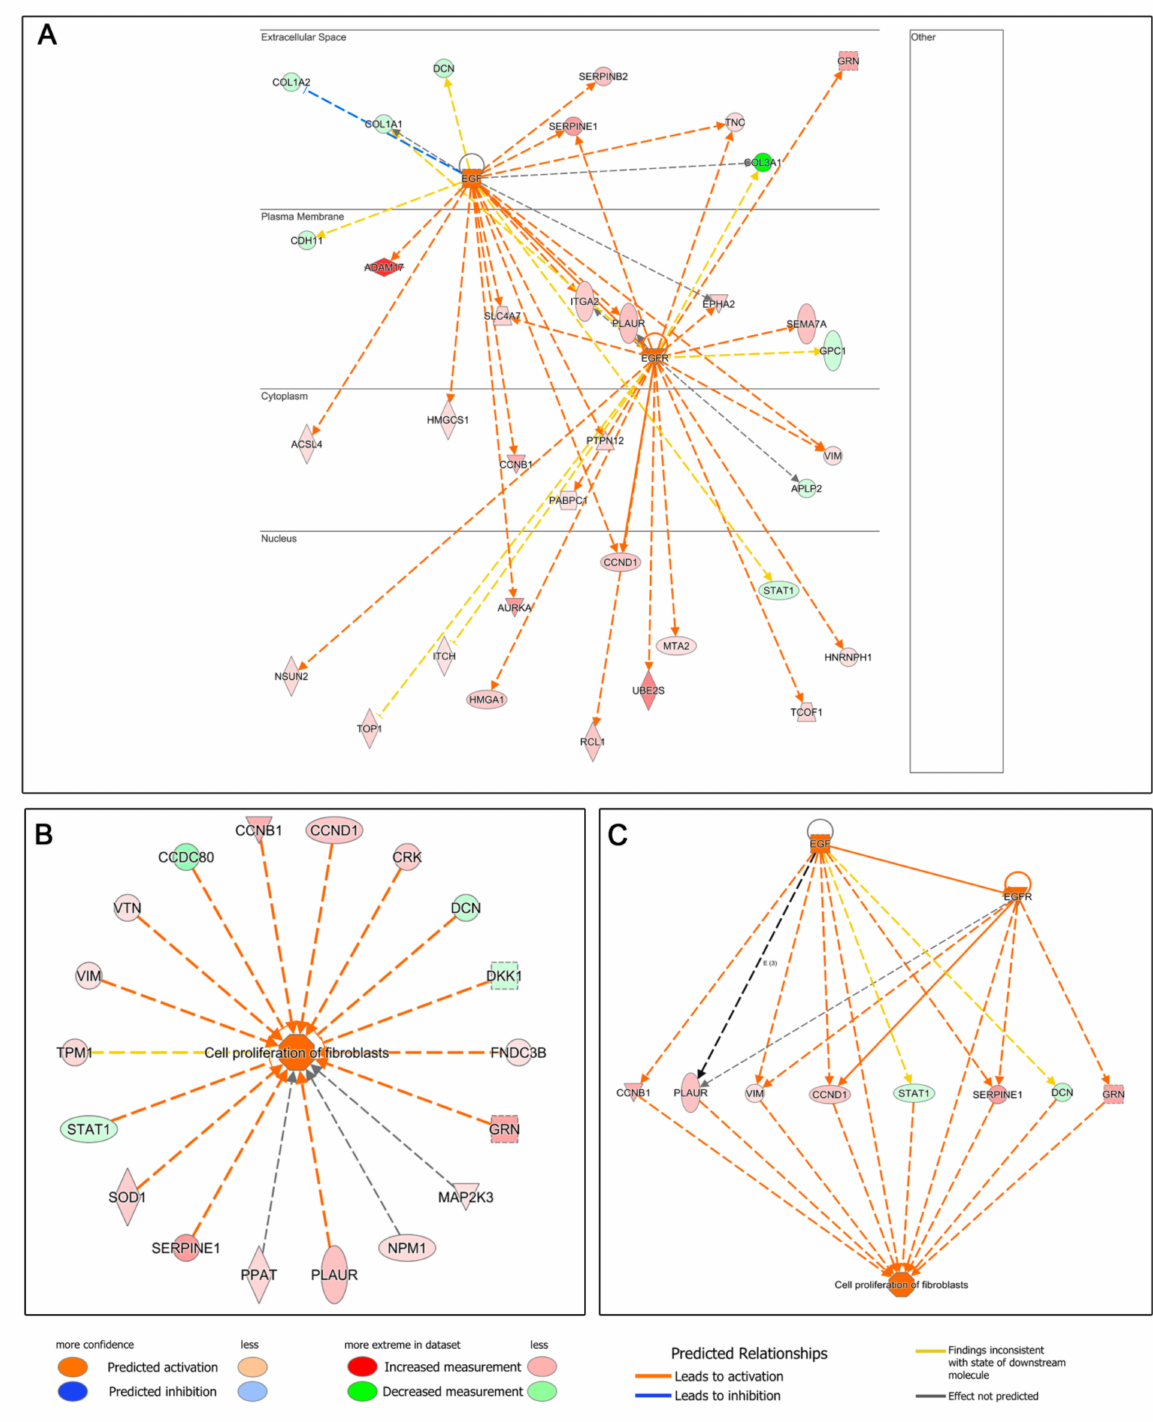
Figure 4. Ingenuity Pathway Analysis (IPA) of deregulated proteins related to the axis of epidermal growth factor (EGF) and EGF receptor (EGFR) in human dermal fibroblasts (HDFs) treated with Endoret serum (ES) extract. ( A ) The IPA upstream regulator analysis suggests that several HDF proteins deregulated with the ES treatment were related to the activation by EGF. ( B ) IPA downstream analysis also showed that numerous deregulated proteins were associated with an induction of the proliferation of fibroblasts. ( C ) Overall, when the upstream and downstream processes were correlated, a relationship between the EGF–EGFR axis and proliferation of HDFs treated with ES was